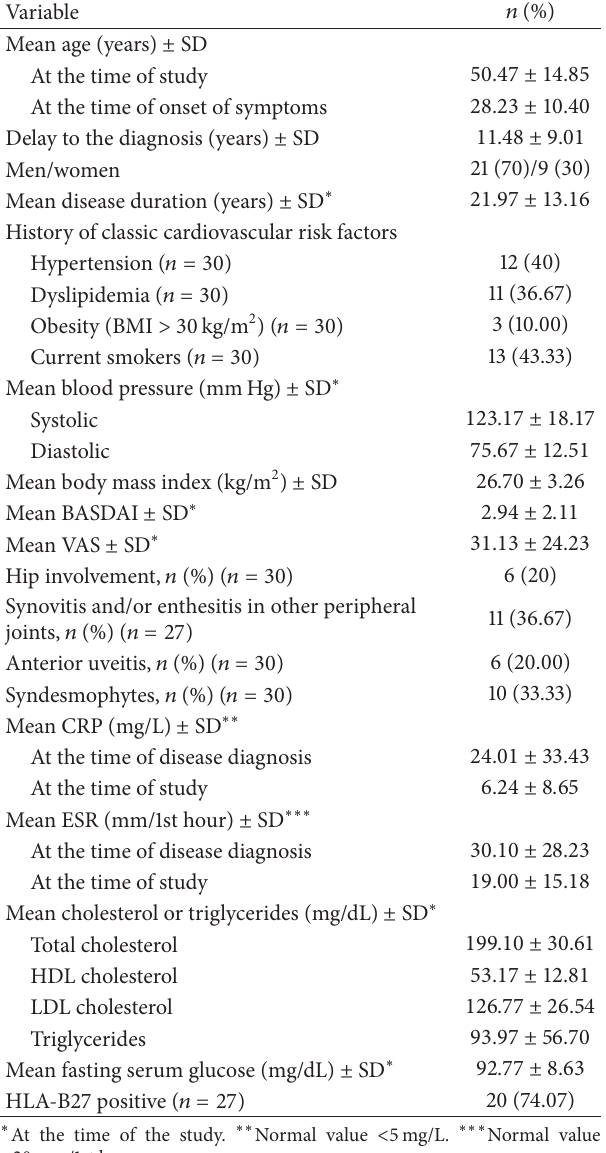
Table 1: Demographic, clinical, and laboratory data of 30 patients with ankylosing